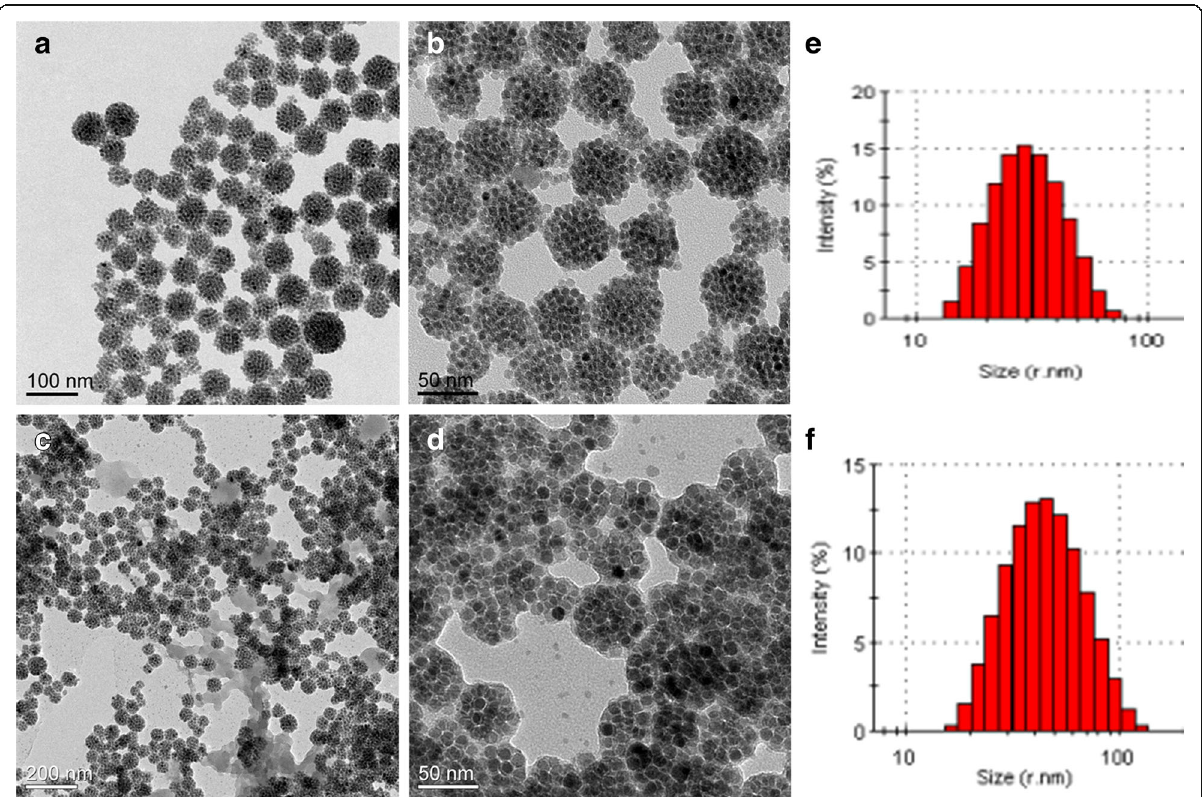
Fig. 2 TEM images of Fe 3 O 4 NCs ( a , b ) and Fe 3 O 4 NC/PAH/PSS ( c , d ) at lower and higher magnification, respectively. Size distribution of Fe 3 O 4 NCs ( e ) and Fe 3 O 4 NC/PAH/PSS hybrid nanostructures ( f